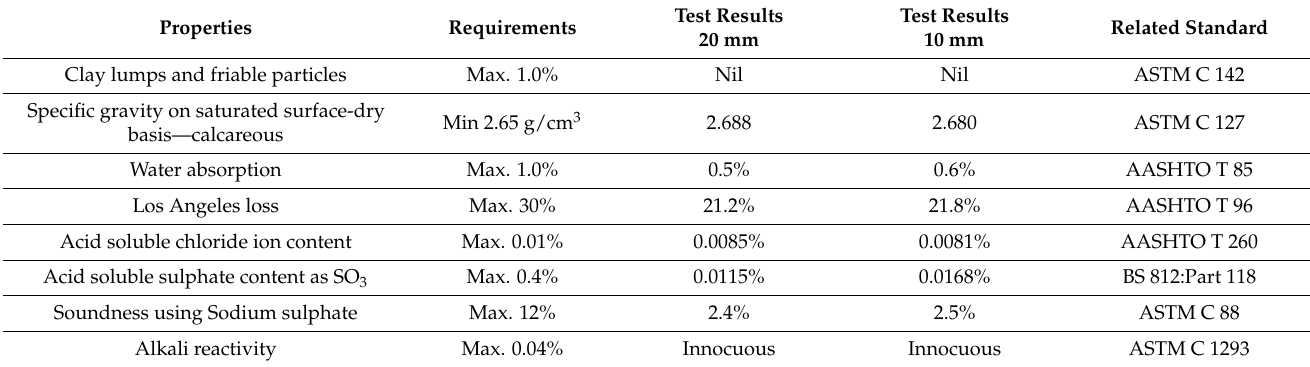
Table 5. Properties, requirements and test results for coarse aggregates [36,43–48].